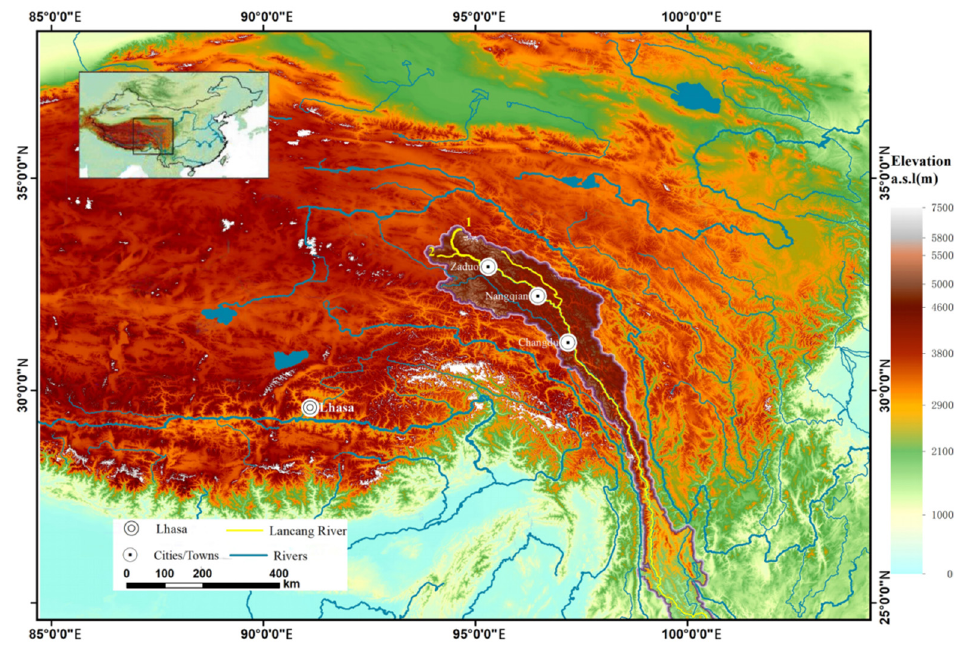
Figure 1. Location and elevation of the Lancang River Basin.